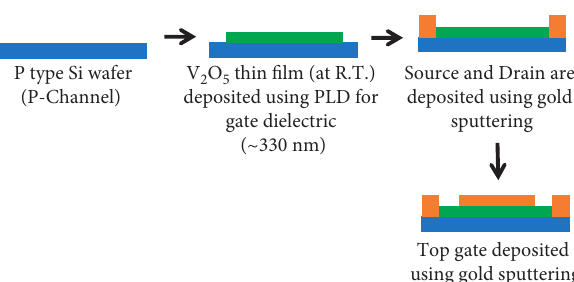
Figure 10: Fabrication steps involved in the V electric-based